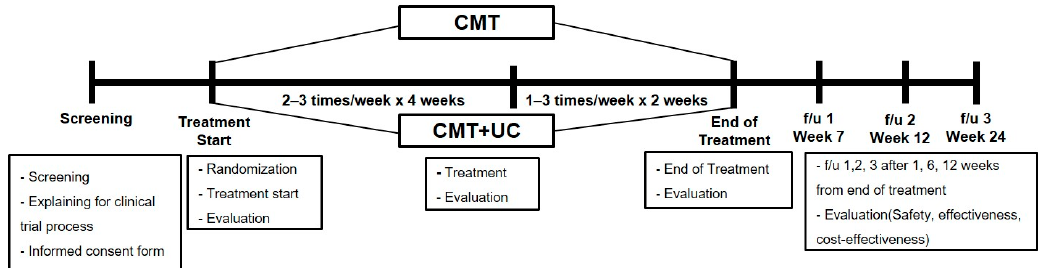
Figure 1. Research process of the study. CMT: Chuna manipulative therapy; UC: usual care; f/u: follow-up.